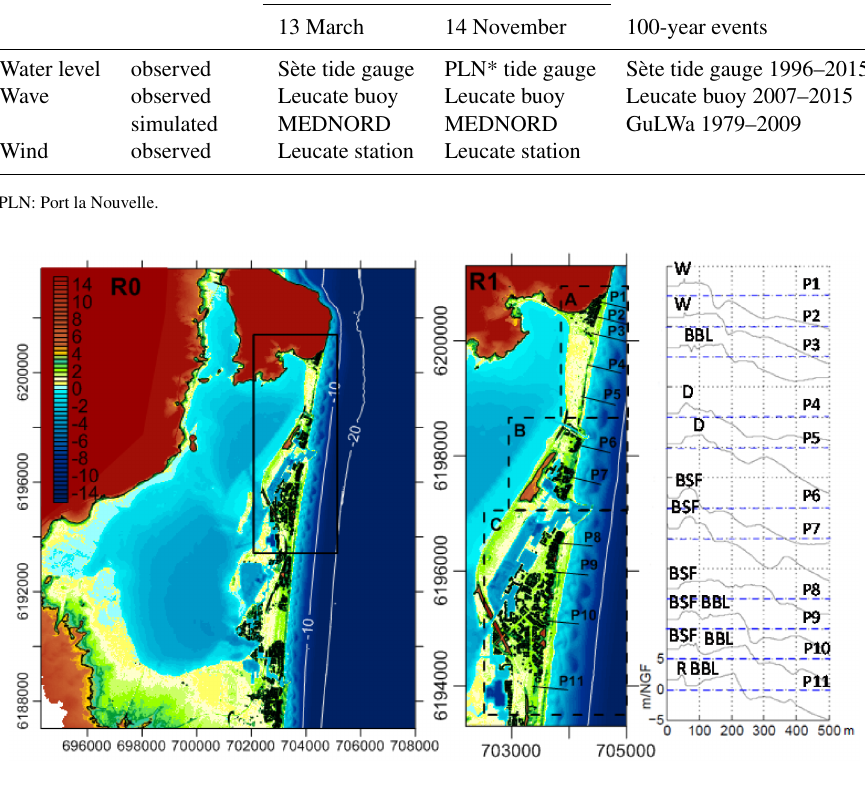
Figure 2. Study site and simulation domains: R 0 (extension 16.5 × 16.5km) resolution 20m, R 1 (extension 3 × 8km) resolution 5m and 11 topobathymetric profiles over three studied zones (A: Leucate Plage; B: the naturist village; C: Port Leucate). Main sea front characteristics are presented as W for sea wall, BSF for built sea front, D for dune, BBL for back beach low and R for